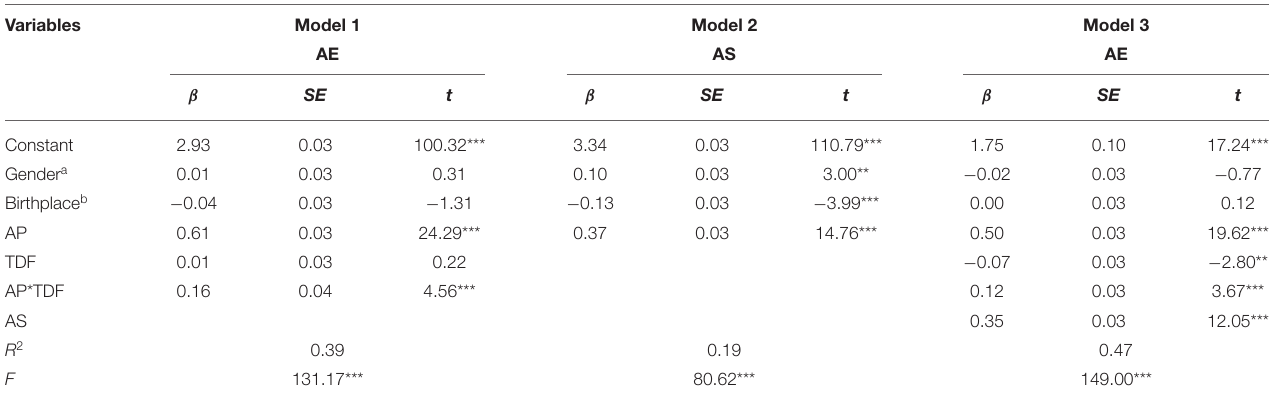
TABLE 2 | Results for the models.